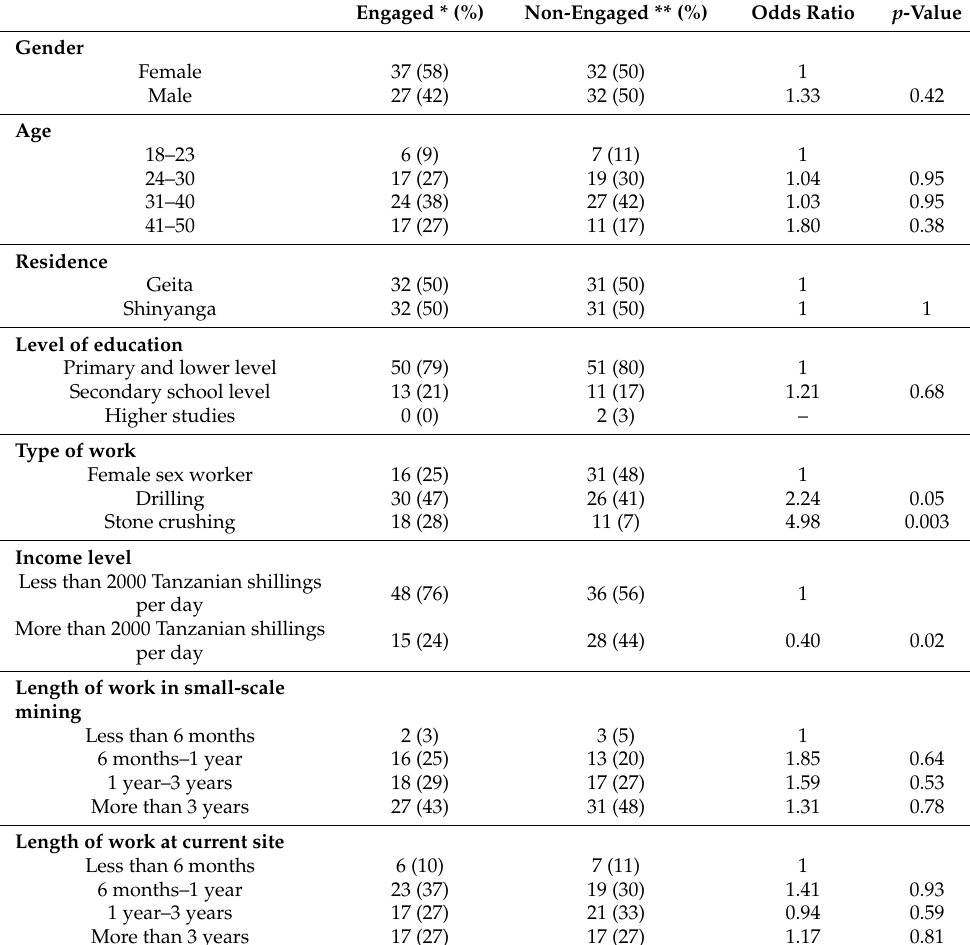
Table 1. General characteristics of ASM and FSW population ( n = 128) and univariate analysis for characteristics associated with engagement or non-engagement with the ACF